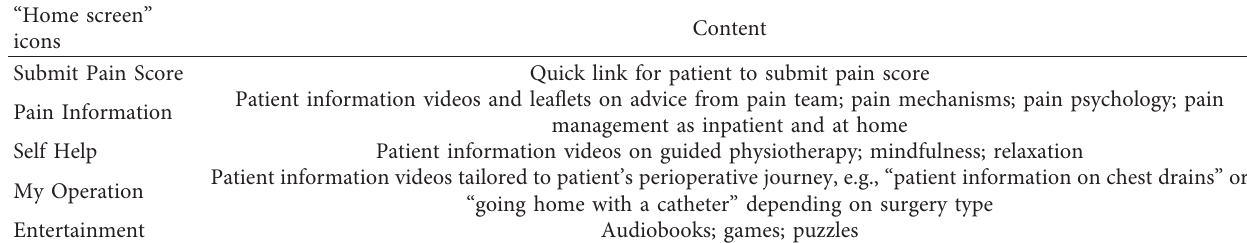
Table 3: Content accessible via MServ home screen.